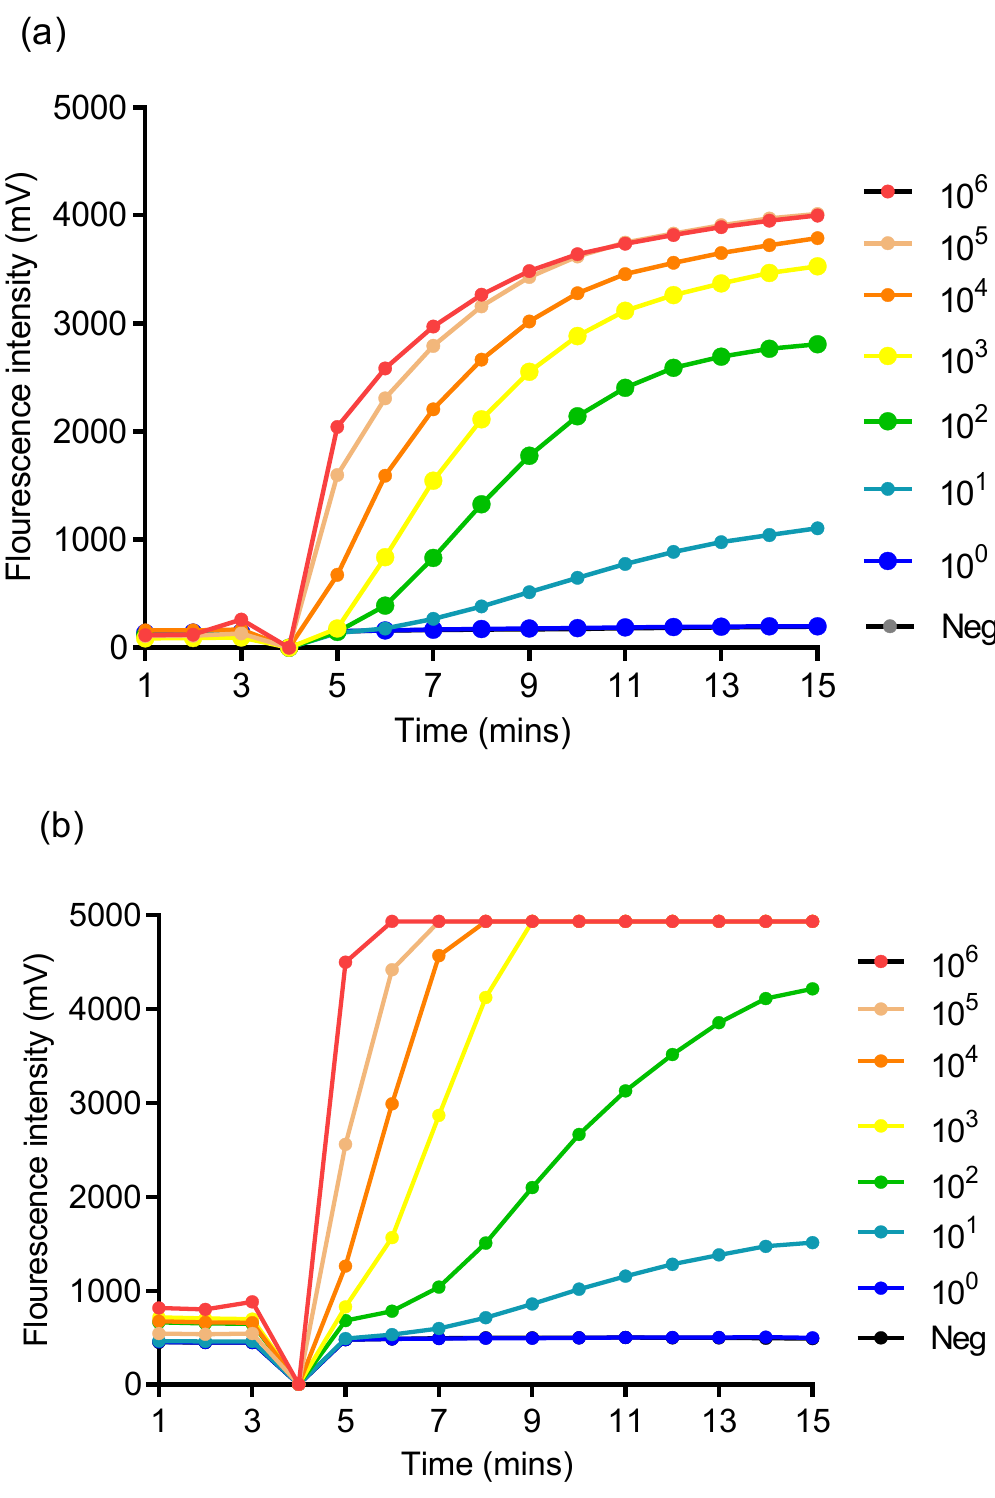
Figure 1. Sensitivity analysis of the singleplex RPA assay using synthetic molecular DNA standard. The assay showed a sensitivity of 10 copies / reaction in T. pallidum and H. ducreyi. RPA reaction tubes were removed and quick vortexed / mixed four minutes after state of amplification and hence no florescence recorded. Sensitivity test for T. pallidum ( a ) and H. ducreyi ( b ). “Neg” is negative control or no template control (NTC).